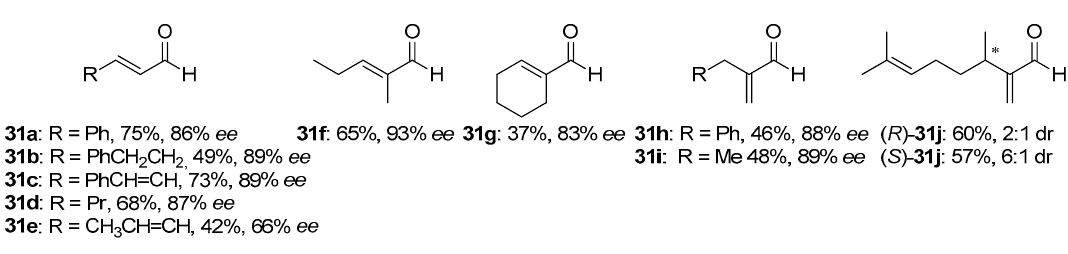
Figure 5. The scope of the reaction employing (+)-METHOX for α , β -unsaturated aldehydes.